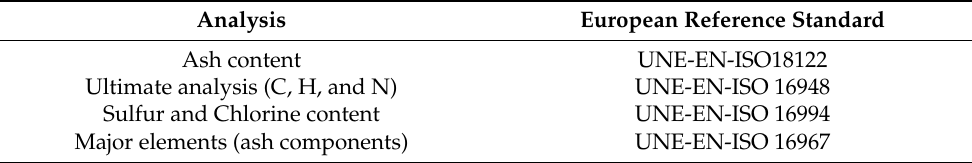
Table 1. Feedstock characterization according to the European reference